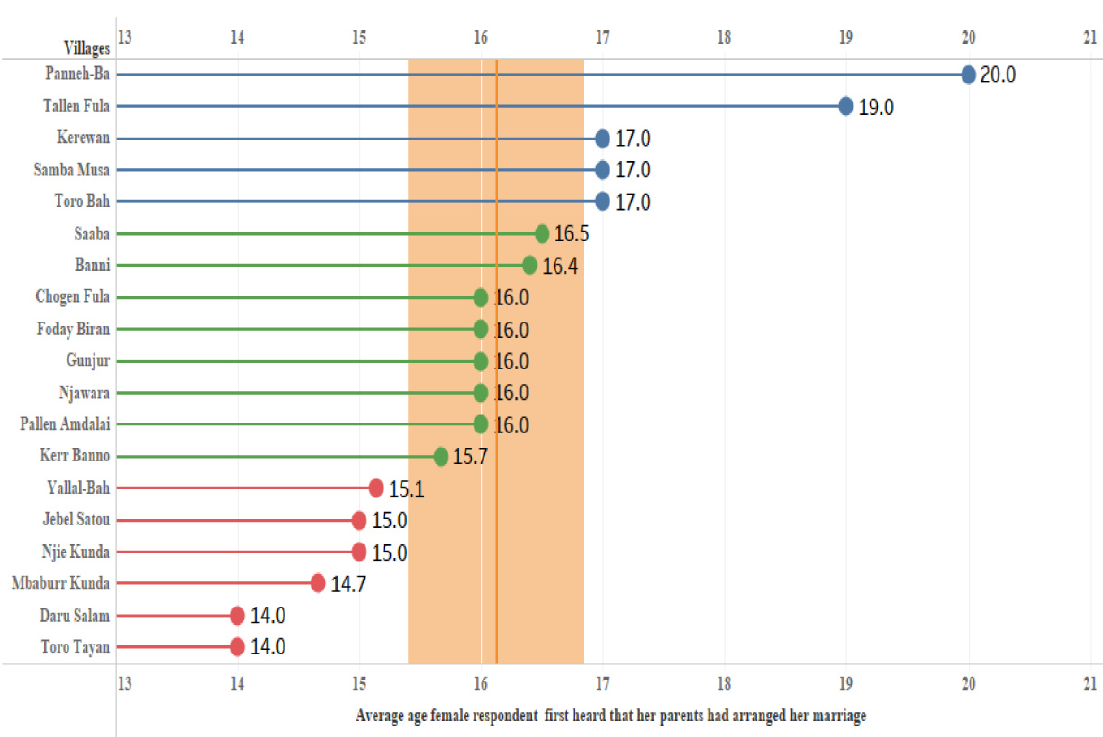
Figure 1. Average age at which a female adolescent first heard that her parents had arranged her marriage. Five villages are not displayed because they have no data on average age at which female adolescent first heard that her parents had arranged her marriage.